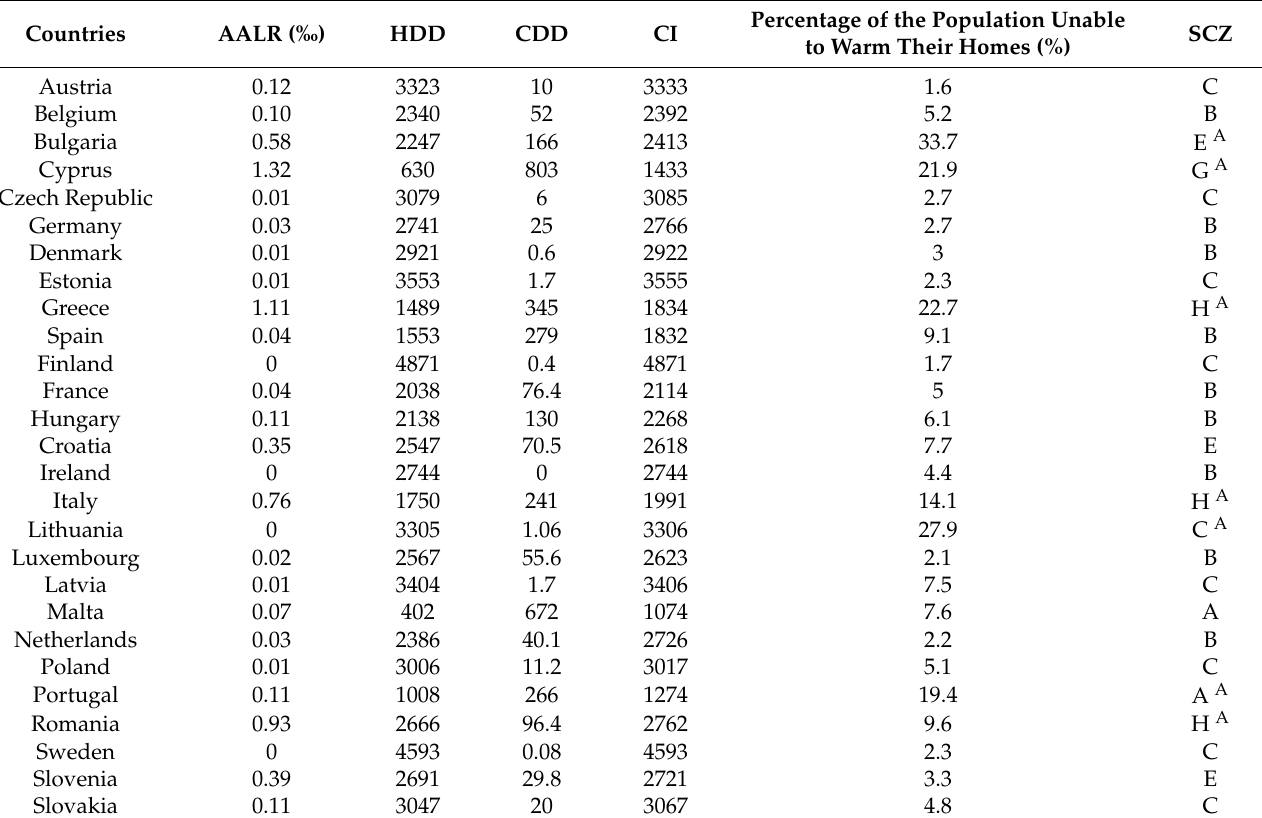
Table 2. Distribution of EU countries over the seismic–climate zones